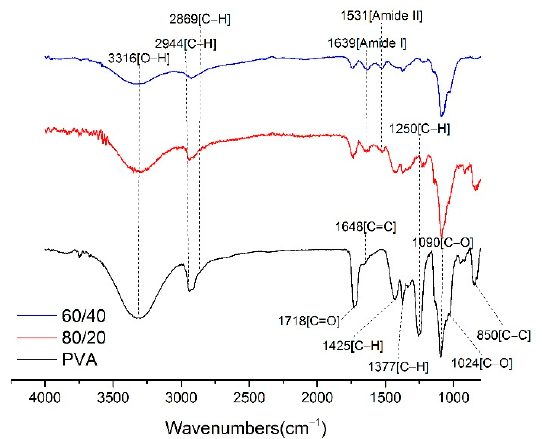
Figure 5. FTIR spectra of PVA/WS-CS nanofibrous membranes.